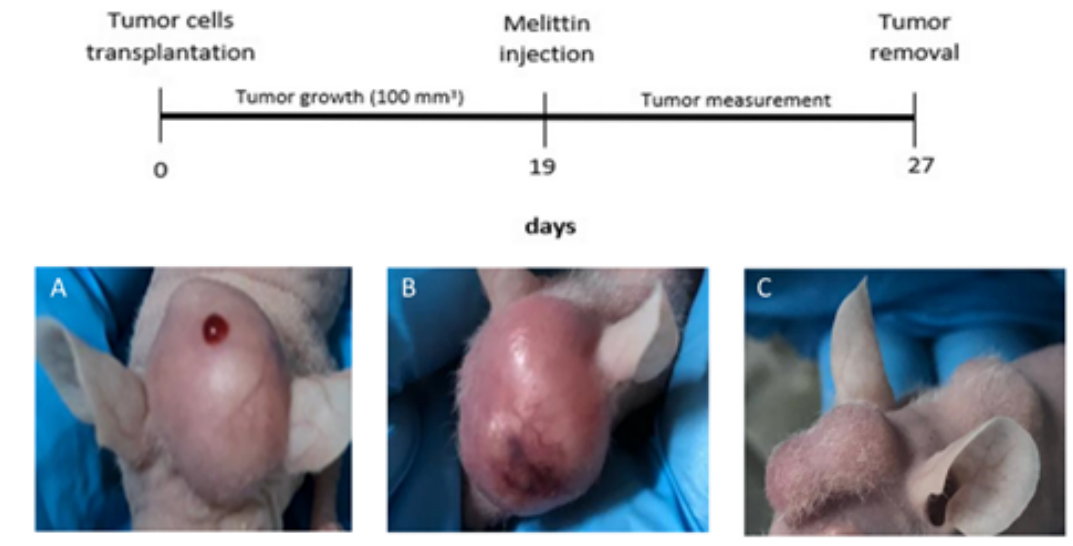
Figure 2. Timeline and CRC bone metastasis progression. (A) On day 19: puncture site by melittin intratumoral injection. (B) On day 20: inflammatory response one day after melittin. (C) On day 27: evident reduction of metastasis size.